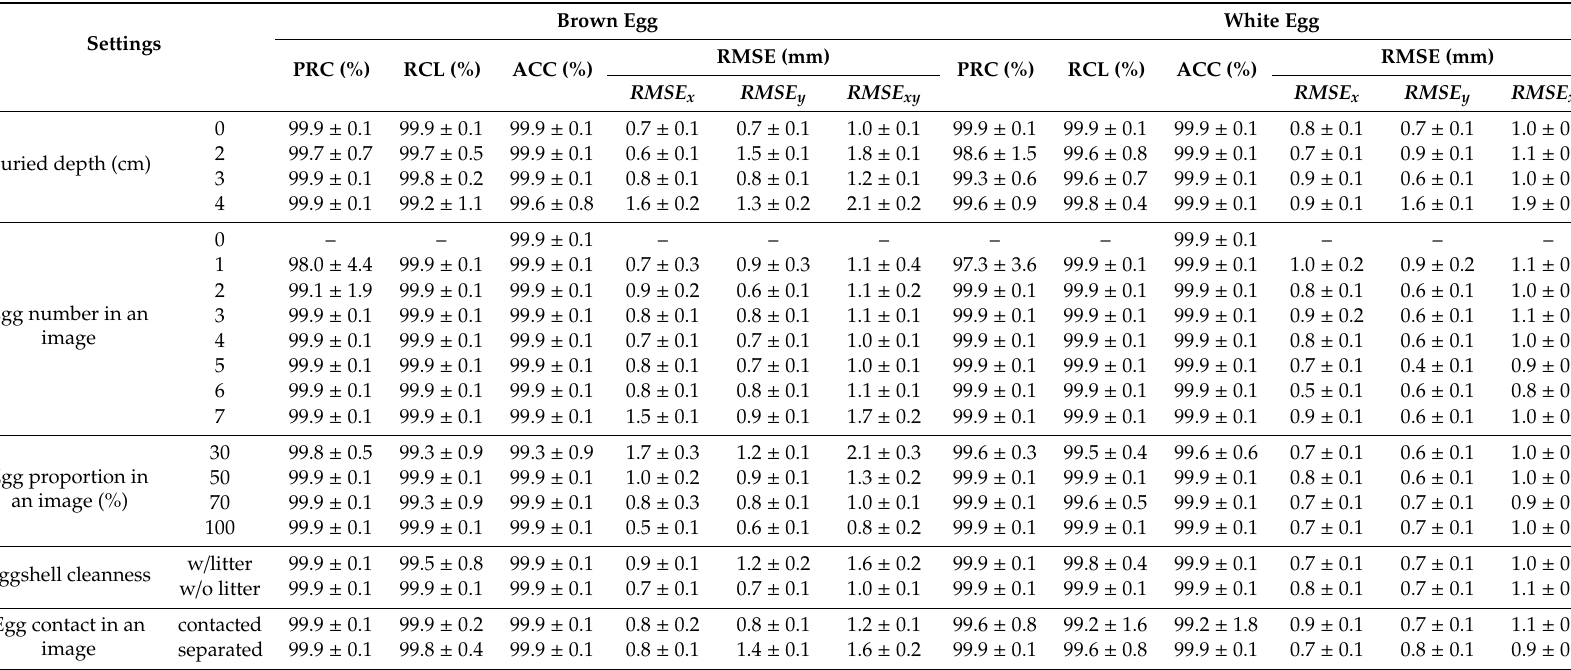
Table 6. Performance (mean ± standard deviation) of the faster region-based convolutional neural network (faster R-CNN) floor-egg detector on floor egg detection under di ff erent egg settings using an average of 40 images of each level of the settings in each of the five events.